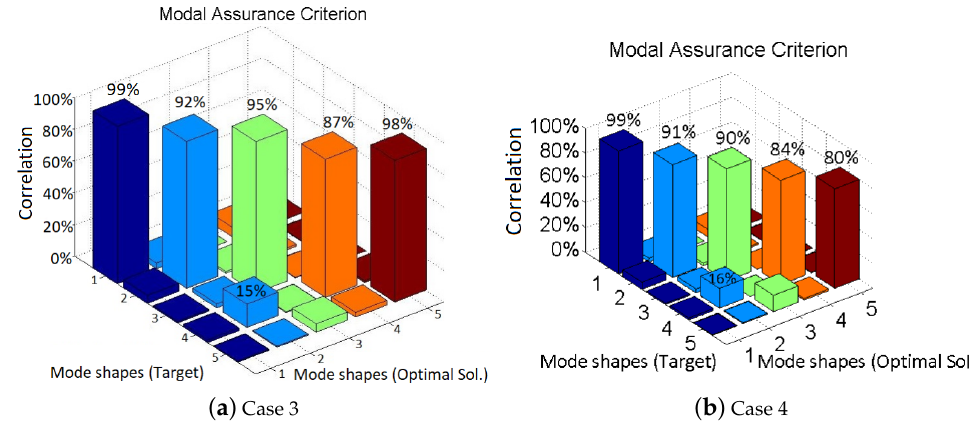
Figure 10. Modal Assurance Criterion for Cases 3 and 4.